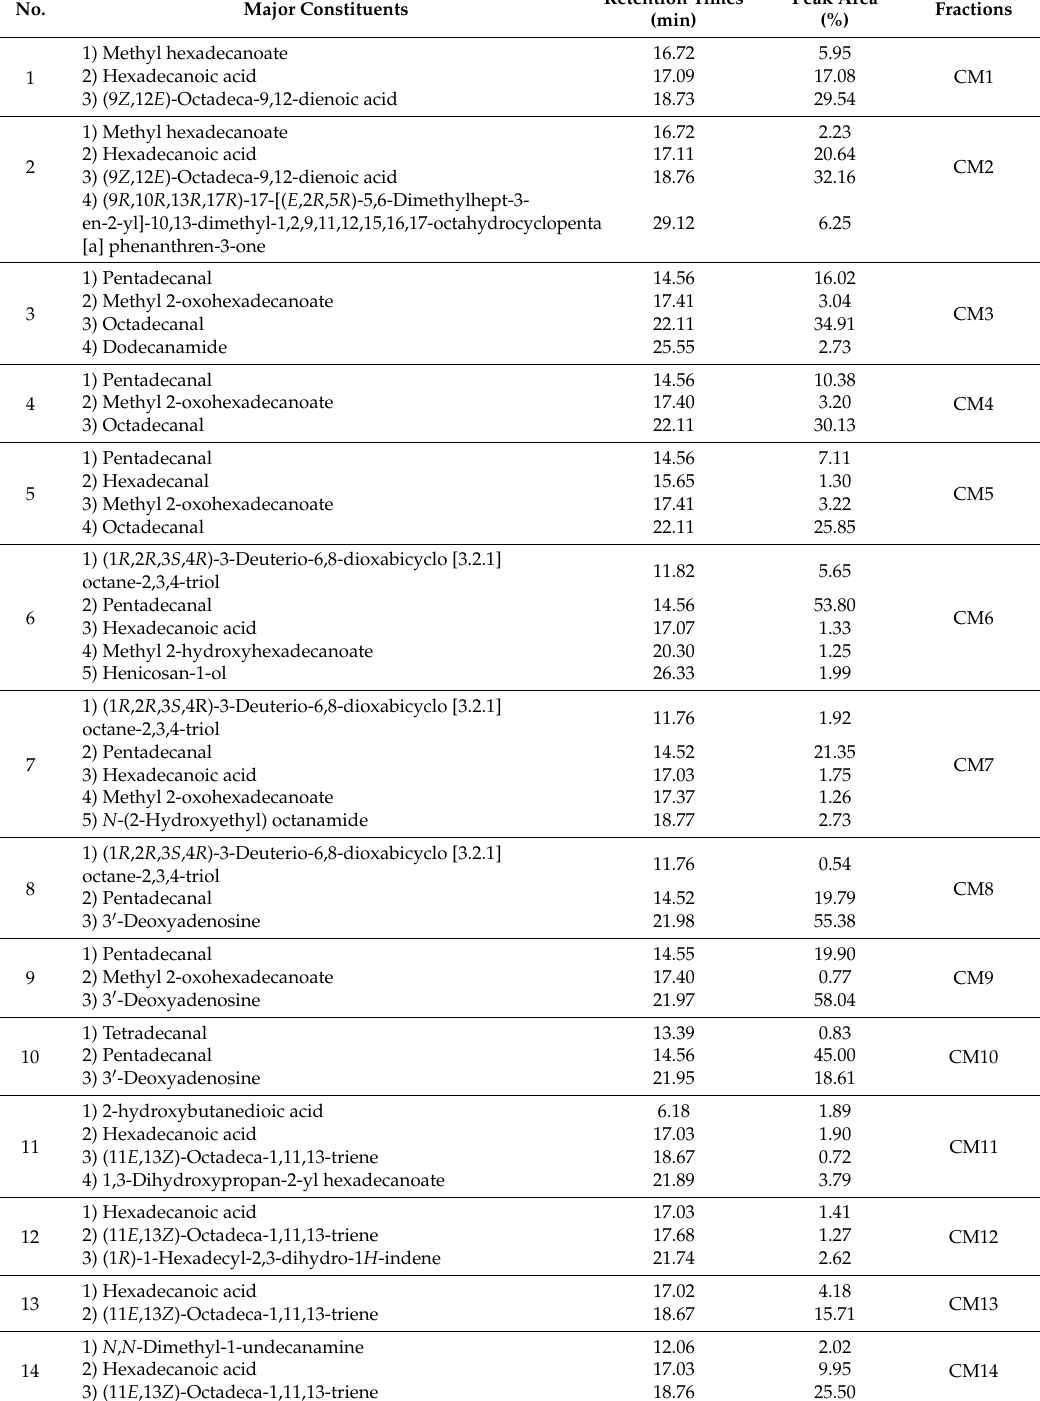
Table 4. Principal compounds identified from different fractions of C. militaris